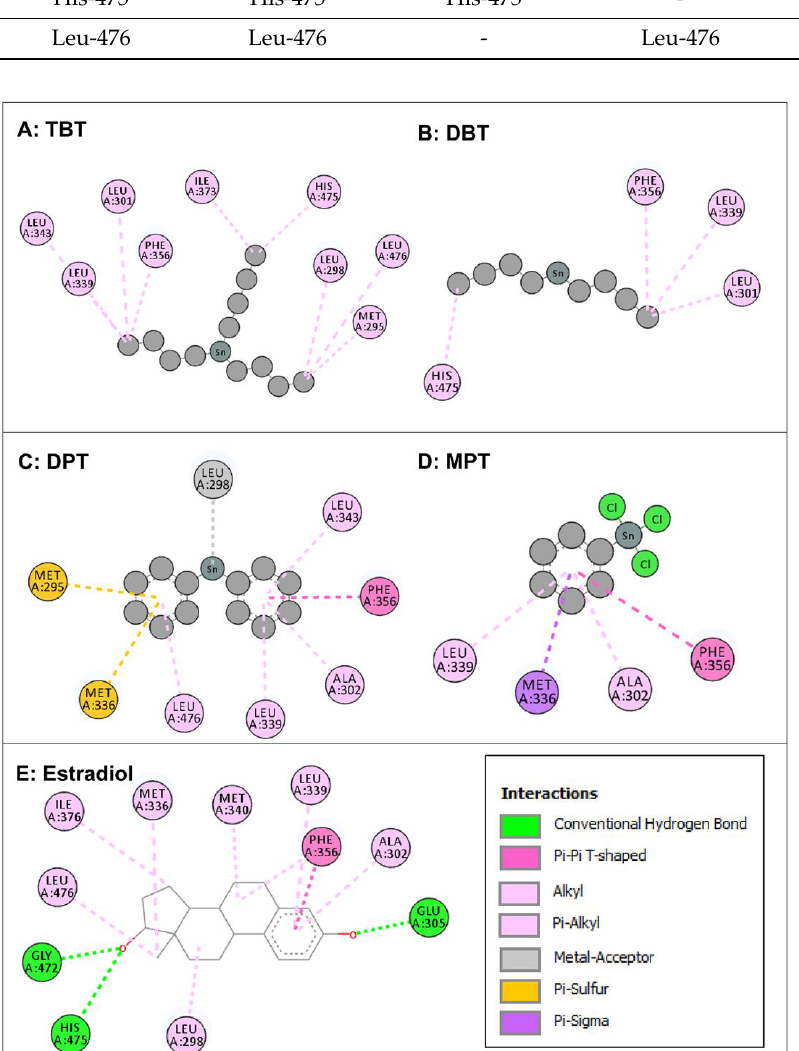
Figure 5. Two-dimensional interaction maps of amino acid residues of estrogen receptor β (ER β ) interacting with four organotin ligands during molecular docking in the ligand-binding site of ER β . Amino acid residue interactions of the bound native ligand of ER β (estradiol) are also shown. Tributyltin (TBT, Panel A ); dibutyltin (DBT, Panel B ); diphenyltin (DPT; Panel C );